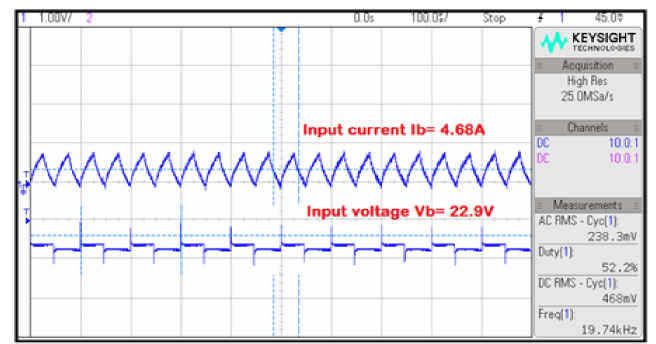
Figure 14. Battery current and